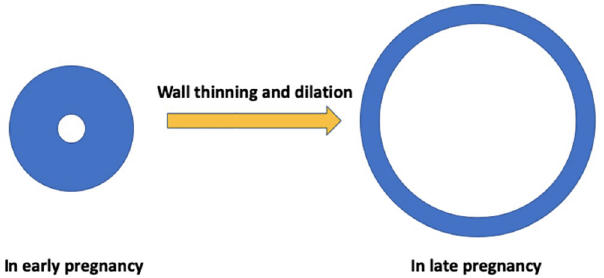
Fig 1. Simple illustration of cervical wall thinning and dilation. Initially the cervix lumen is small and the wall is thick. Gradually the wall becomes thinner and the lumen area increases. Such dimensional changes accommodate the need for a smooth